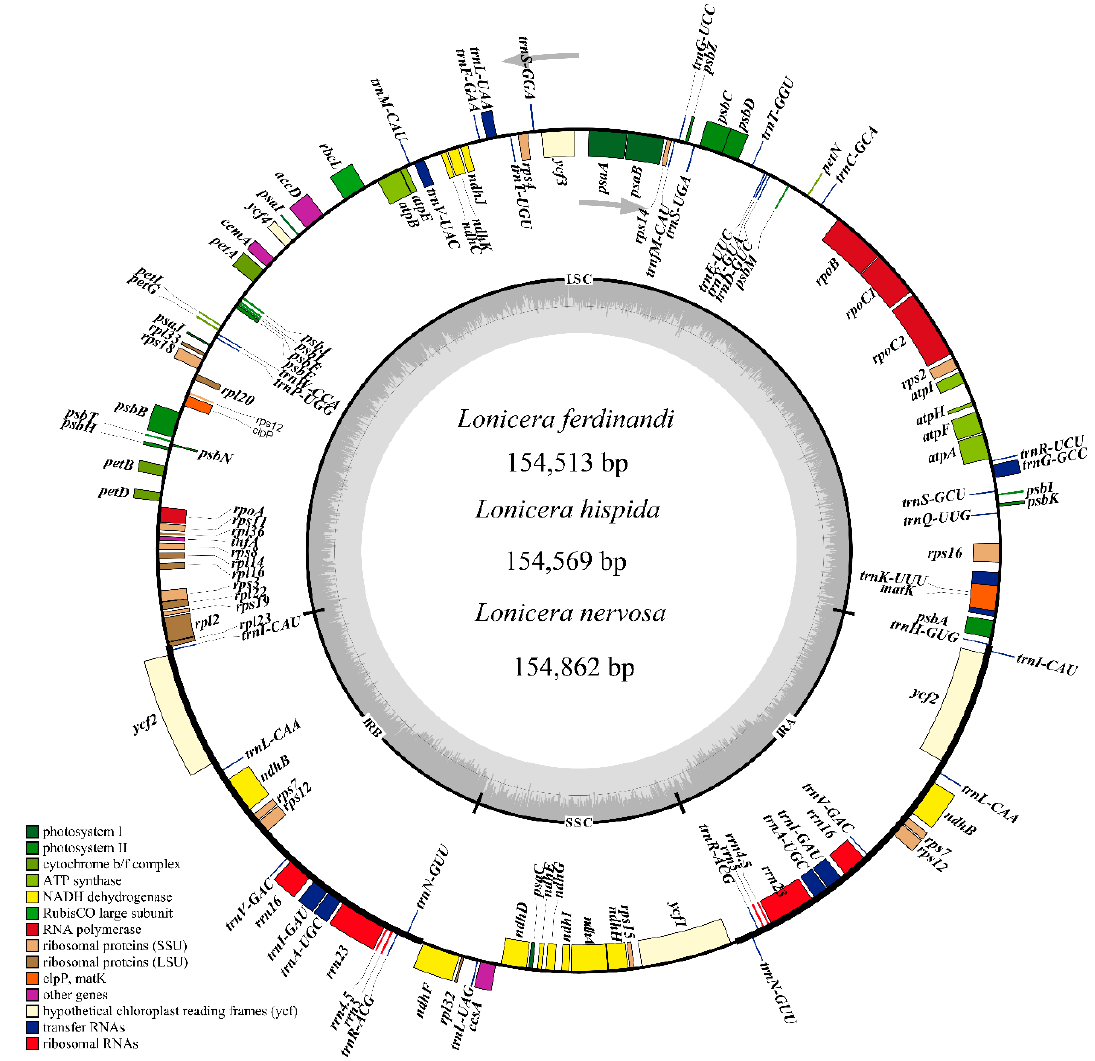
Figure 1. Chloroplast genome map for three Lonicera species. Genes located outside the outer rim are transcribed in a counterclockwise direction, whereas genes inside the outer rim are transcribed in a clockwise direction (as indicated by grey arrows). The colored bars indicate known different functional groups. The dashed gray area in the inner circle shows the percentage GC content of the corresponding genes. LSC, SSC, and IR denote large single copy, small single copy, and inverted repeat, respectively.